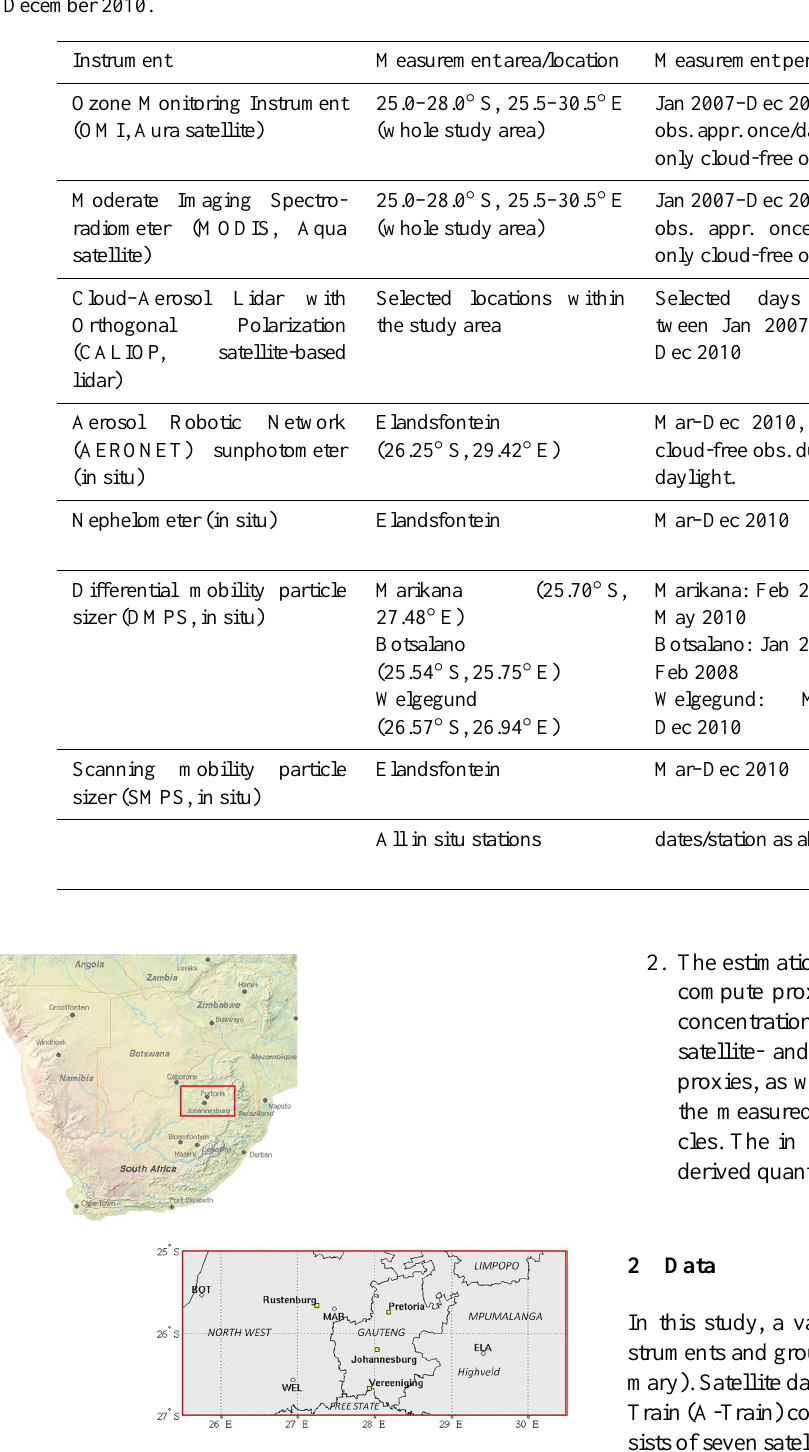
Figure 1. The study area and locations of the in situ measurement stations; BOT = Botsalano, MAR = Marikana, WEL = Welgegund, and ELA =